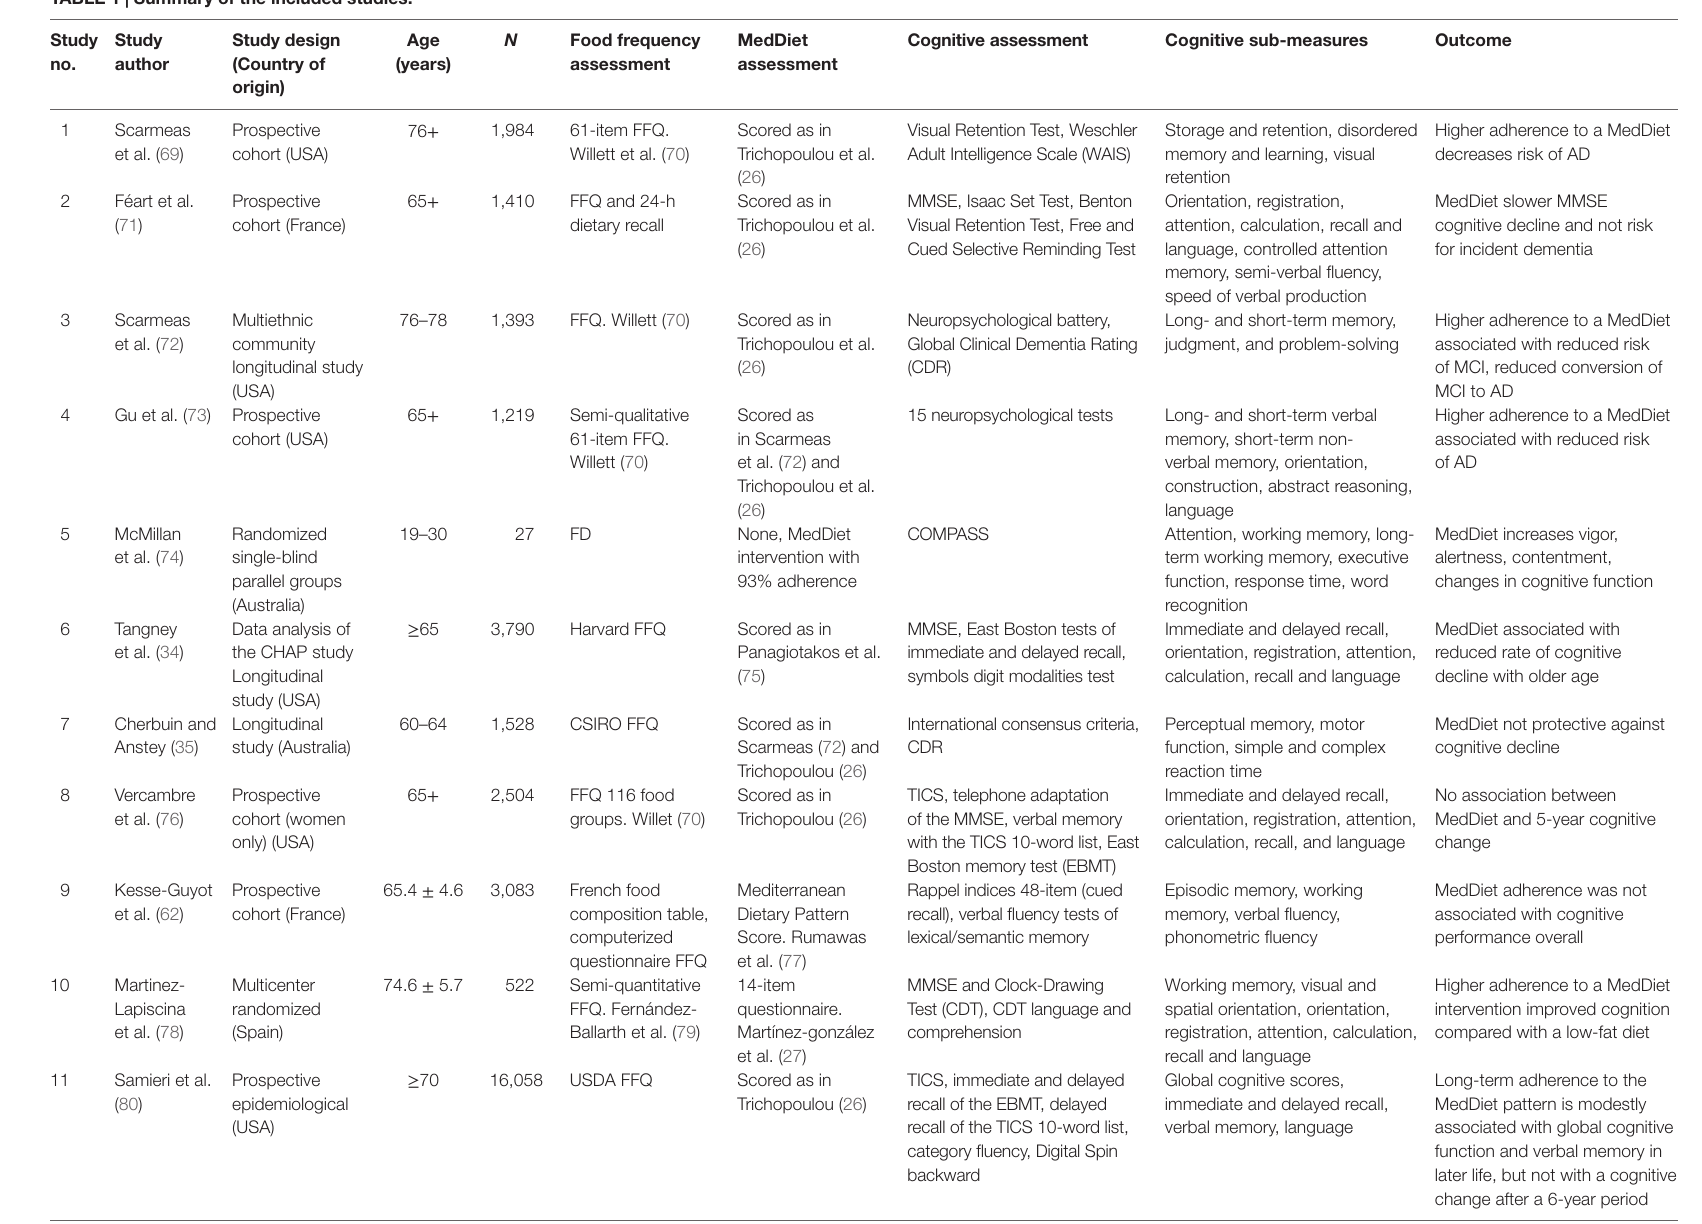
TABLe 1 | Summary of the included studies. Study